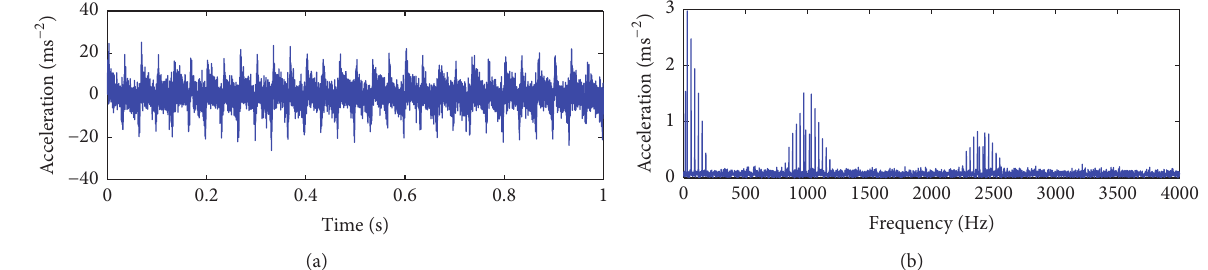
Figure 1: Time waveform (a) and frequency spectrum (b) of the simulation